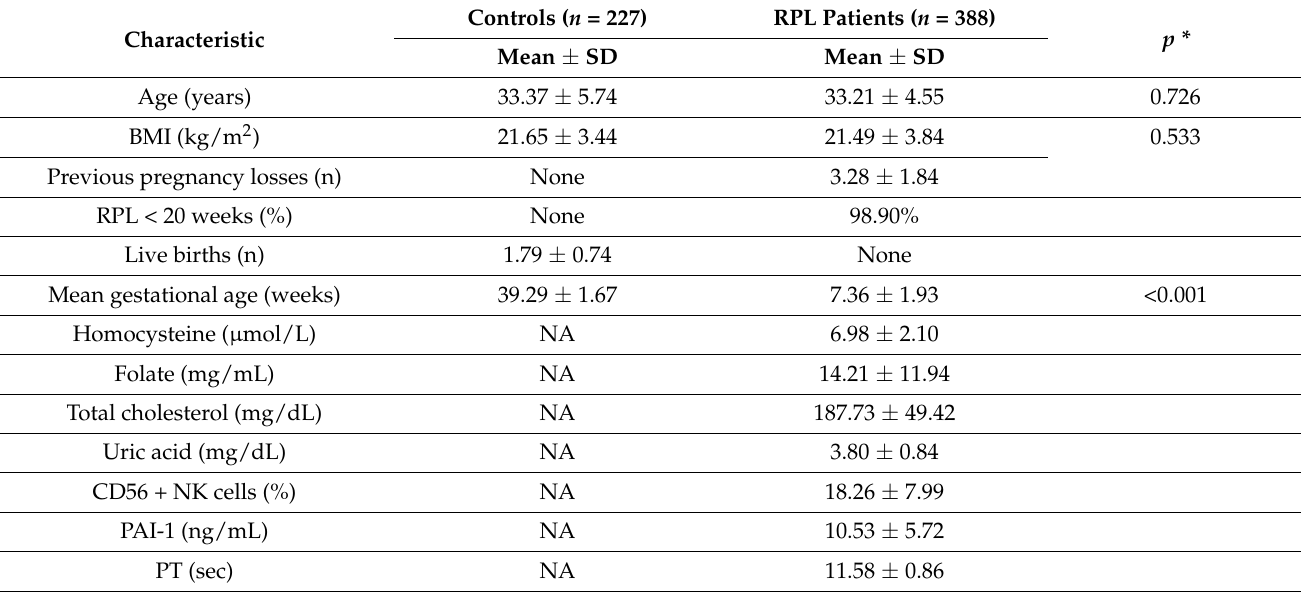
Table 1. Clinical characteristics of RPL patients and